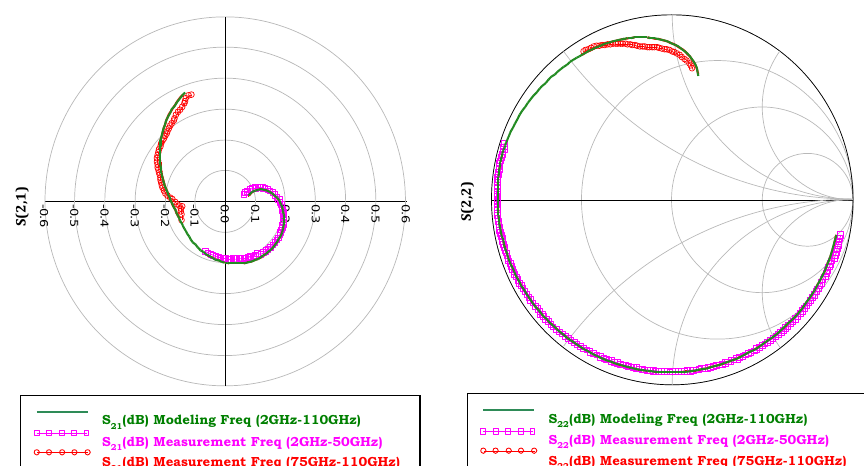
Figure 7. Modelled and measured [S]-parameters of the unbiased diode (0 V) after the de-embedding in the wire bonding configuration.